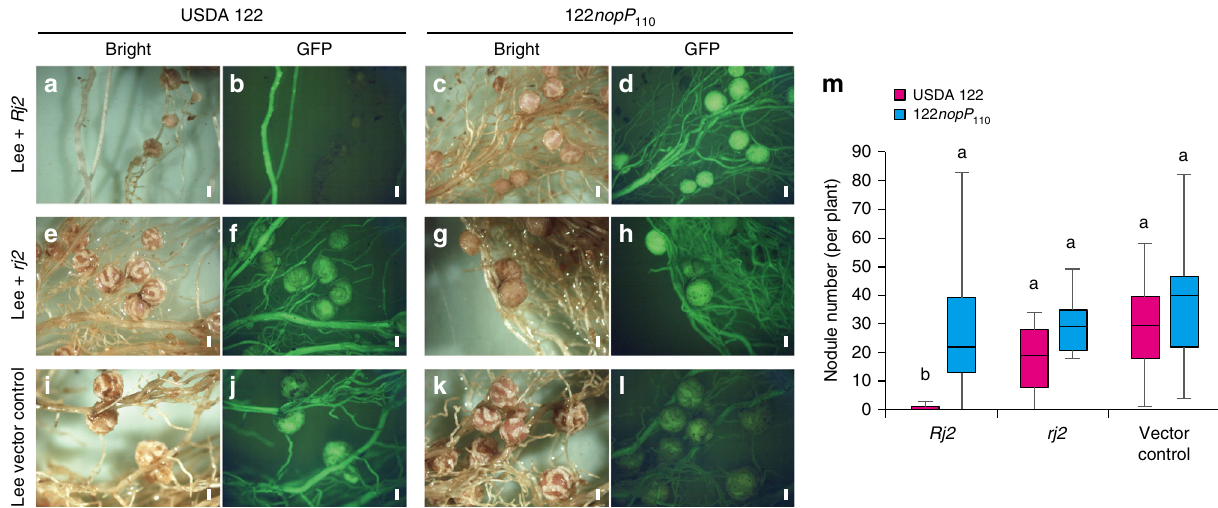
Fig. 5 Nodulation of rj2 -soybean transformed with the Rj2 gene by USDA 122 or 122 nopP 110 . a , c , e , g , i , k Bright- fi eld images and b , d , f , h , j , l GFP fl uorescence images of roots of transgenic cv. Lee ( rj2 ) complemented with the Rj2, rj2 gene or vector control. B. diazoef fi ciens USDA 122 or 122 nopP inoculated onto each seedling, and images were taken at 4 weeks after inoculation. Scale bars, 1 mm. m Box-and-whisker plots showing the number of nodules formed on GFP-expressing hairy roots. Combined data from three independent experiments are shown. Center line, median; box limits, fi rst and third quartiles; whiskers, ranges. n = 14 for Rj2 , n = 12 for rj2 , and n = 13 for vector control. Different letters above bars indicate statistical signi fi cance ( P < 0.01 by nonparametric Steel – Dwass multiple comparison test)